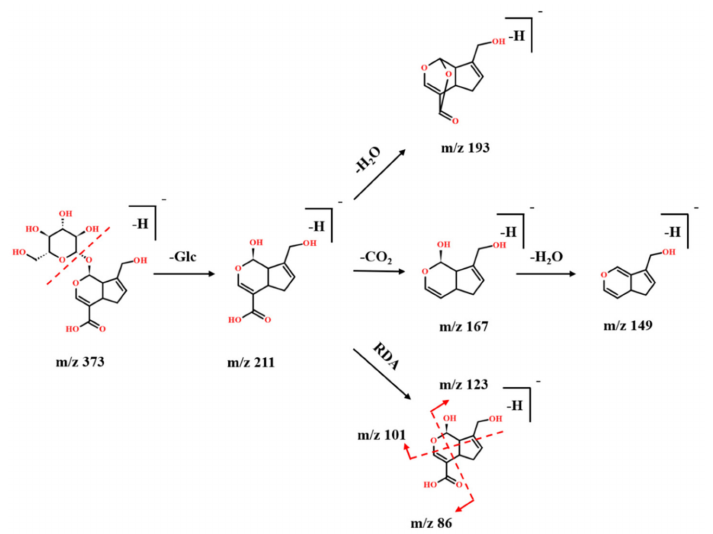
Figure 2. The possible fragmentation pathways of geniposidic acid (Compound 9) in the negative ion mode.